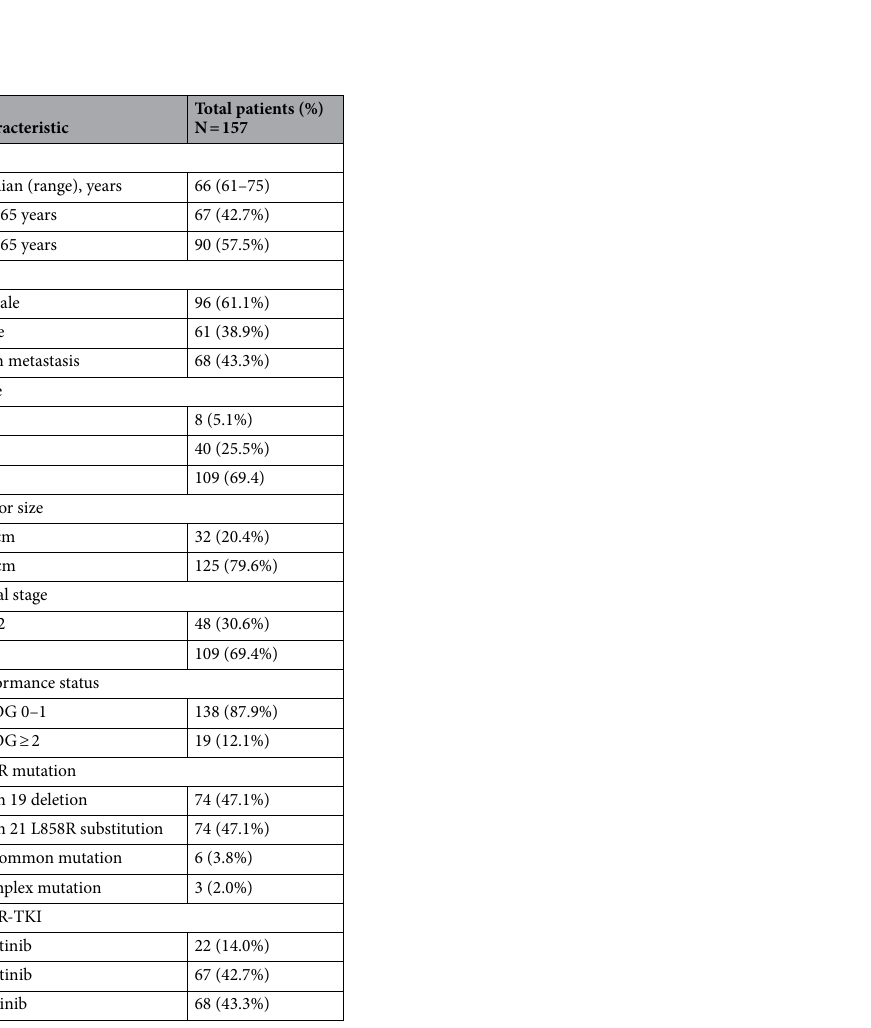
Table 1. Patient characteristics. EGFR, epidermal growth factor receptor; TKI, tyrosine kinase